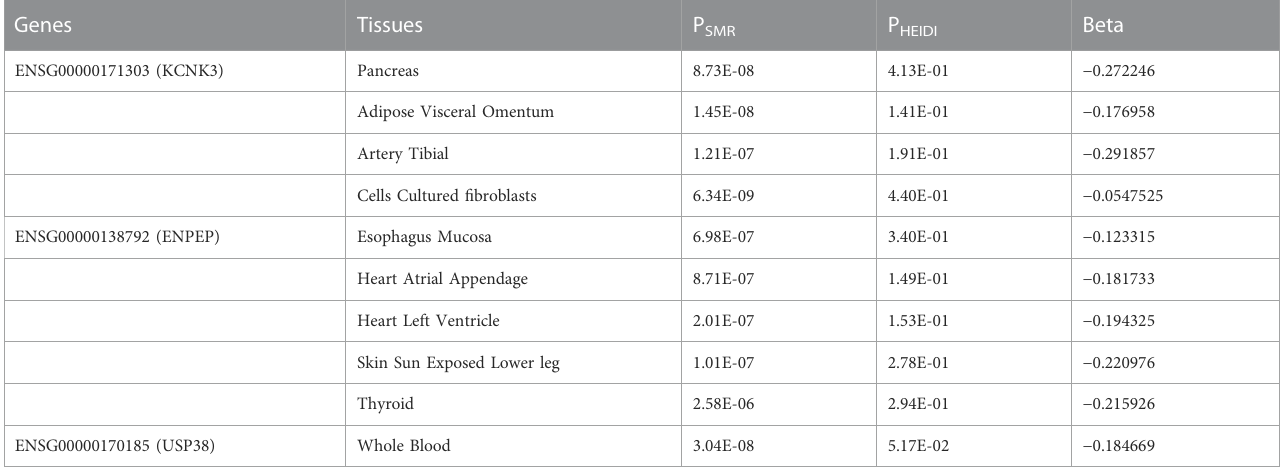
TABLE 3 SMR validates the association of 5 genes in different tissues. Genes